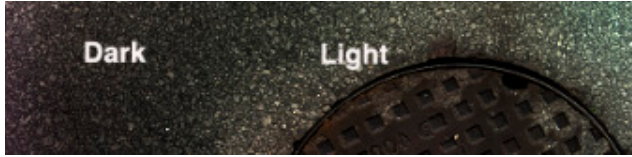
Figure 10. Darker and lighter areas of a scanned image and also found in many other images.